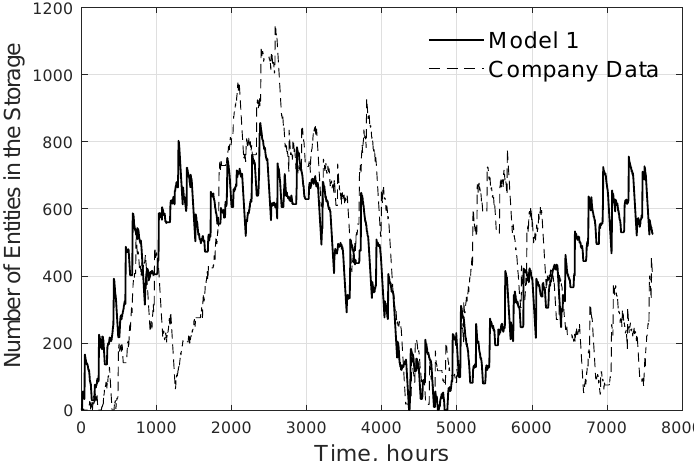
Figure 15. One example result of total inventory level of entities as predicted by model 1 and indicated by the company